Question: Compose a caption that would accompany this figure in a paper.
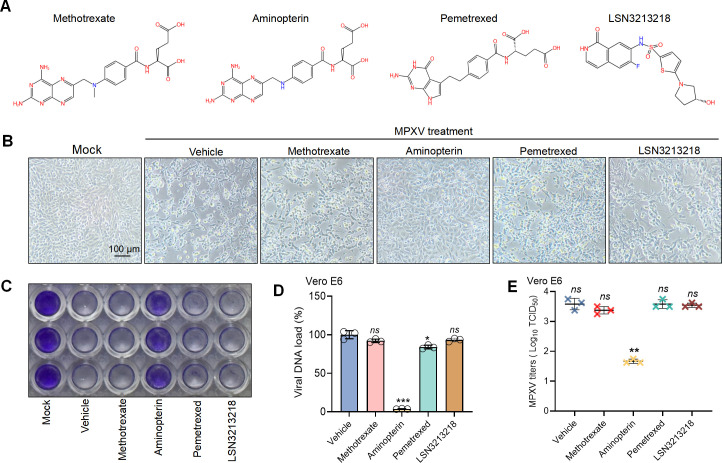
Answer: Screening of anti-MPXV infection among the folate antagonists. ( A ) Chemical structures of MTX, aminopterin, pemetrexed, or LSN3213218 are shown. ( B and C ) Vero E6 cells were treated with MTX, aminopterin, pemetrexed, or LSN3213218 at 100 nM following MPXV (1 × 10 4 PFU) infection for 48 h. Morphology changes in MPXV-infected cells following the drug treatment were assessed by light microscopy (scale bar: 100 μm), followed by crystal violet staining to quantify cytoprotection. ( D ) Viral DNA load reduction rate of MPXV infection by MTX, aminopterin, pemetrexed, or LSN3213218 was calculated via qPCR analysis of intracellular viral DNA ( n = 3, independent experiments). ( E ) Viral titers in cell supernatants from panels B and C were determined by TCID 50 assay ( n = 3, independent experiments). Data expressed as means of technical replicates ± SD, and one-way analysis of variance ( D and E ) and SNK-q test ( D and E ) were performed in this section (* P < 0.05, ** P < 0.01, and *** P < 0.001, ns: not significant).